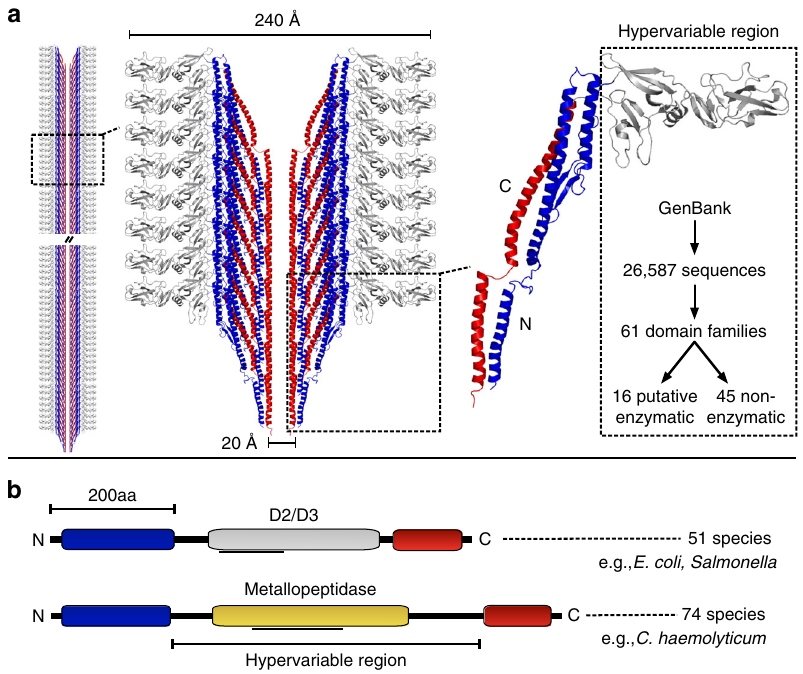
Fig. 1 Structural model of the fl agellar fi lament and identi fi cation of uncharacterized surface-exposed fl agellin domains. a Structural model of the fl agellar fi lament and constituent fl agellin proteins ( left ), highlighting the interior fl agellin N-terminal ( blue ) and C-terminal ( red ) domain and the surface-exposed hypervariable region domain ( gray ). The model is based on the structure of FliC from Salmonella (PDB 1ucu). Flagellin hypervariable regions from the NCBI GenBank database were analyzed, revealing 61 putative domain families including several with potential enzymatic function. b Schematic depiction of the commonly studied D2/D3 fl agellin domain variant, as well as the novel putative metallopeptidase domain predicted within 74 species. The gray lines below the domains indicate regions matched by the Conserved Domain Database, which were manually re fi ned through subsequent